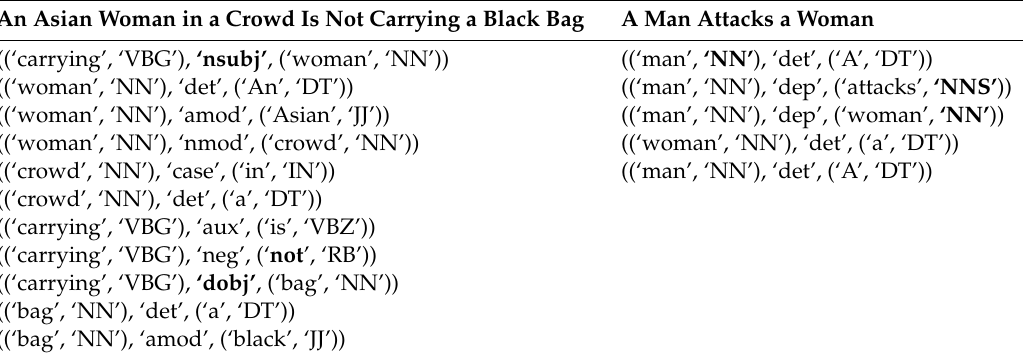
Table 3. Results produced by the Stanford